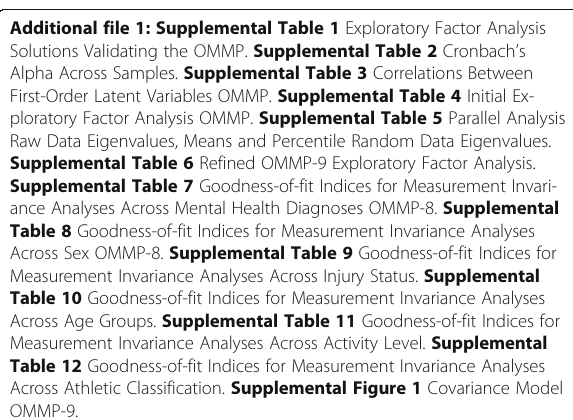
Additional file 1: Supplemental Table 1 Exploratory Factor Analysis Solutions Validating the OMMP. Supplemental Table 2 Cronbach ’ s Alpha Across Samples. Supplemental Table 3 Correlations Between First-Order Latent Variables OMMP. Supplemental Table 4 Initial Ex- ploratory Factor Analysis OMMP. Supplemental Table 5 Parallel Analysis Raw Data Eigenvalues, Means and Percentile Random Data Eigenvalues. Supplemental Table 6 Refined OMMP-9 Exploratory Factor Analysis. Supplemental Table 7 Goodness-of-fit Indices for Measurement Invari- ance Analyses Across Mental Health Diagnoses OMMP-8. Supplemental Table 8 Goodness-of-fit Indices for Measurement Invariance Analyses Across Sex OMMP-8. Supplemental Table 9 Goodness-of-fit Indices for Measurement Invariance Analyses Across Injury Status. Supplemental Table 10 Goodness-of-fit Indices for Measurement Invariance Analyses Across Age Groups. Supplemental Table 11 Goodness-of-fit Indices for Measurement Invariance Analyses Across Activity Level. Supplemental Table 12 Goodness-of-fit Indices for Measurement Invariance Analyses Across Athletic Classification. Supplemental Figure 1 Covariance Model